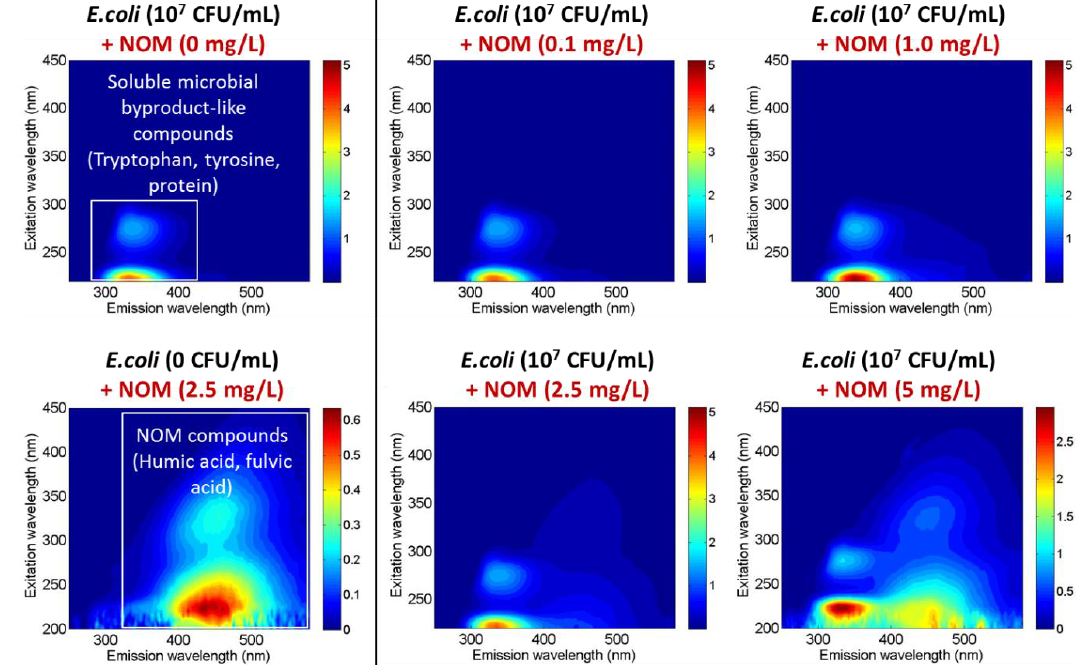
Figure 7. The FL-EEMs of either E. coli & Natural Organic Matter (NOM) in DI water.